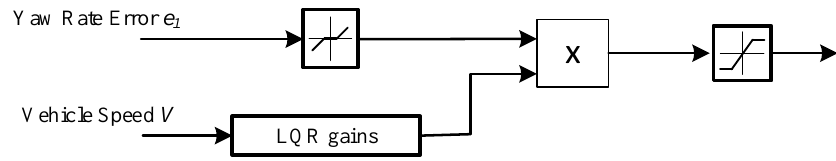
Figure 5. Linear Quadratic Regulator controller scheme.